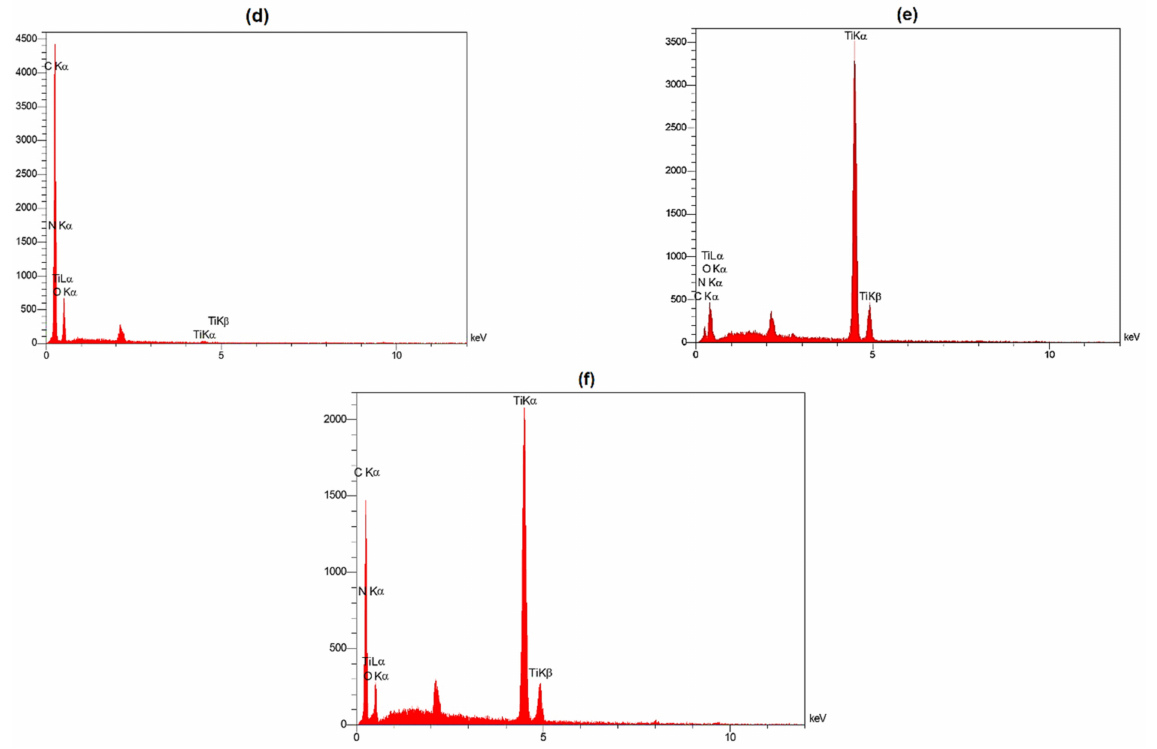
Figure 6. SEM micrographs of bauxite-embedded TiH 2 with magnifications of ( a ) 100 × , ( b ) 1000 × , and ( c ) 3000 × . EDX analysis of PFR-embedded TiH 2 powder from ( d ) A, ( e ) B, and ( f ) C